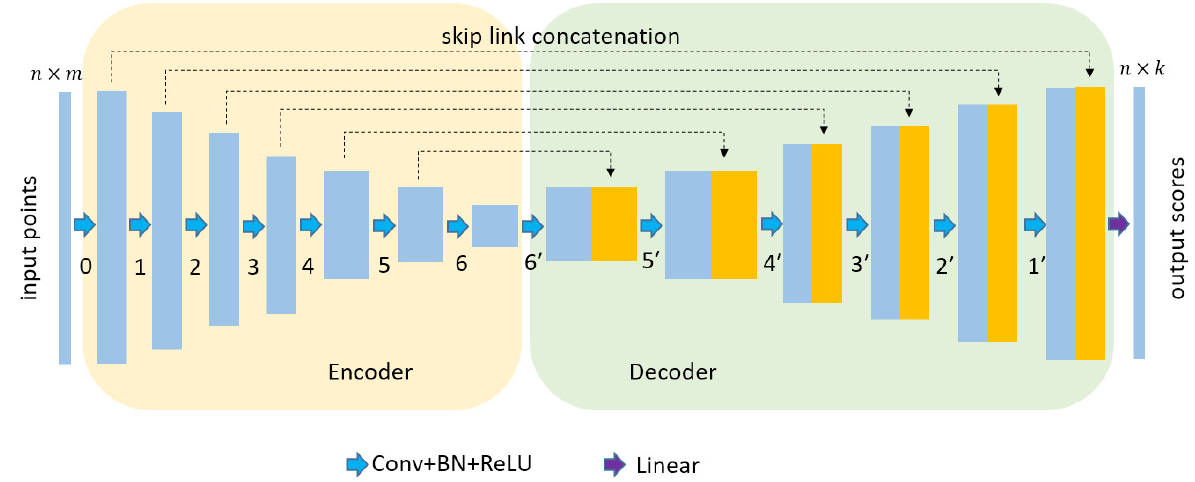
Figure 4. Illustration of the proposed classification network architecture. The network is composed of encoder and decoder parts. Table 1. The number of points and feature dimensions of input and output points of each convolu- tion layer.